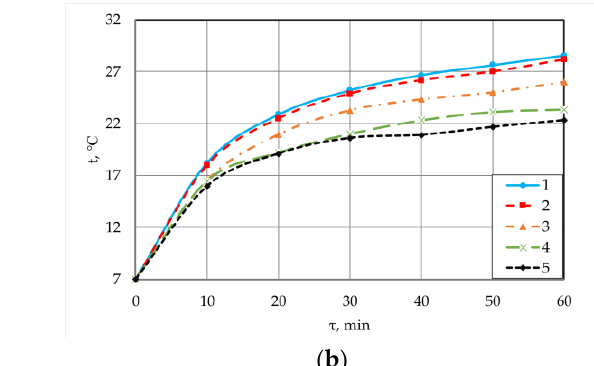
Figure 5. Air temperatures change ( a ) with increasing time on the left X = 0.8 m (solid line) and on the right X = 2.4 m (dashed line) from the panel at points at a distance of 0.2 m; 1.0 m; 2.0 m from the floor and changes in panel surface temperatures; ( b ) (1 – 5 thermocouples location in accordance with Table 2 and Figure 2).